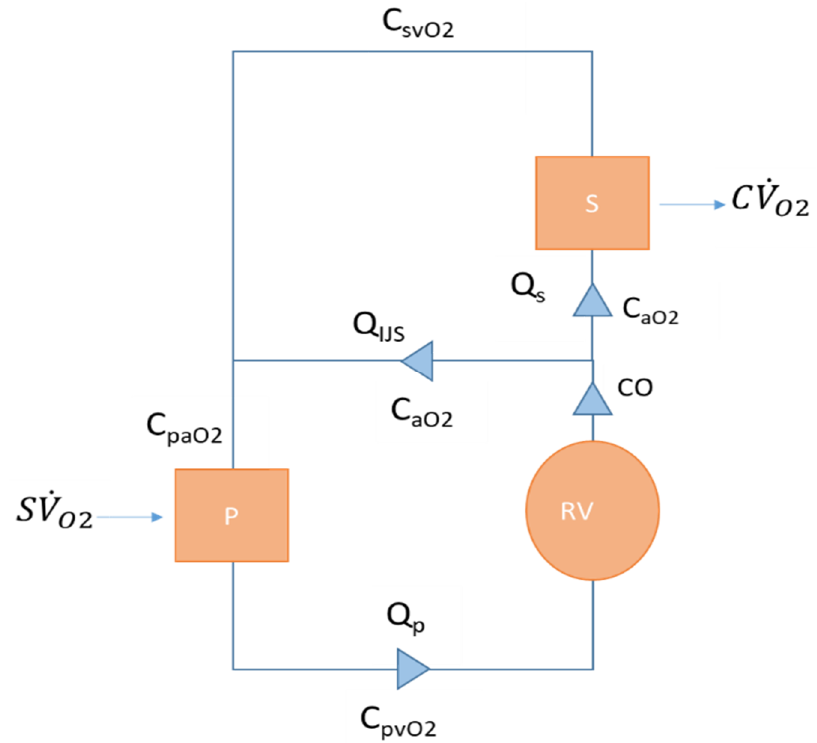
Figure 7. Oxygenation model for Fontan